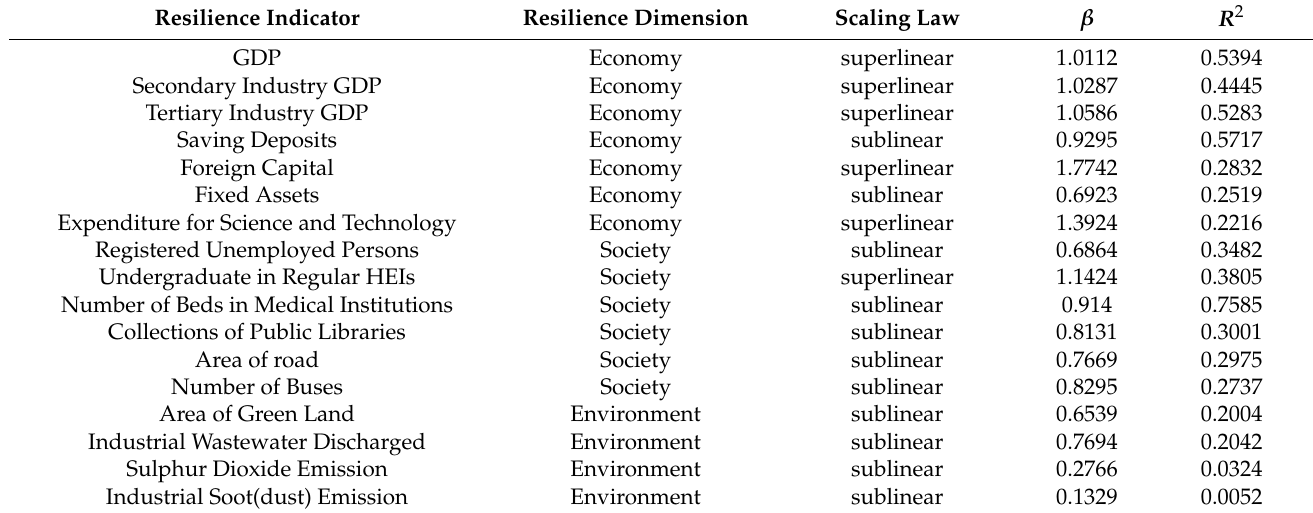
Table 2. Scaling parameters for urban resilience indicators in China in